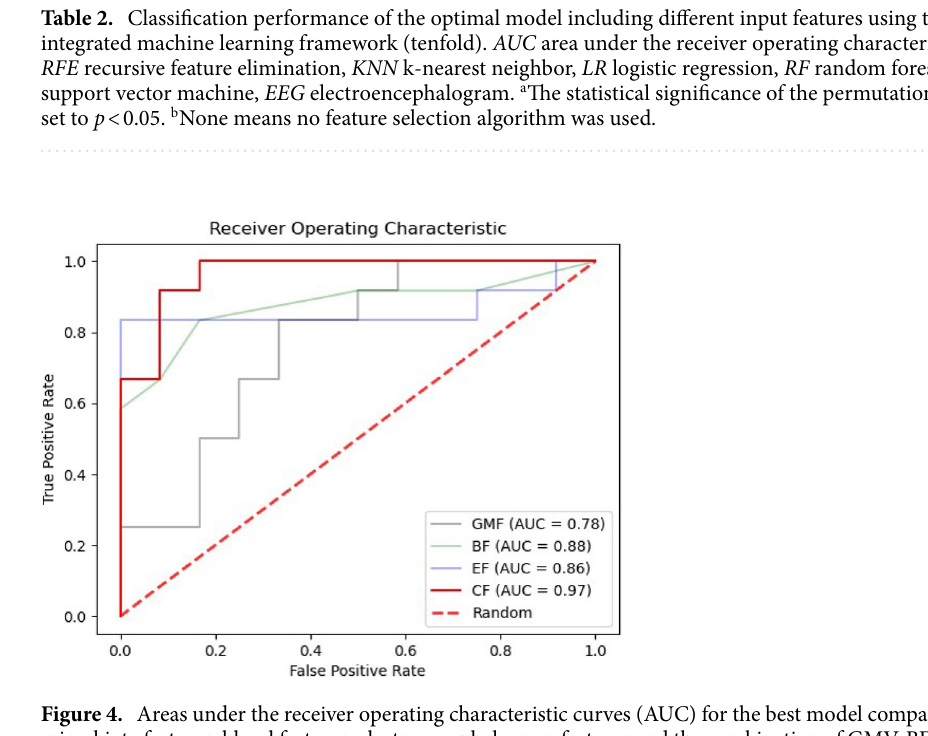
Figure 4. Areas under the receiver operating characteristic curves (AUC) for the best model comparing the gut microbiota features, blood features, electroencephalogram features and the combination of GMV, BF and EF as the input for machine learning. Each curve in the figure represents the ROC curve of the best model using different input features. GMF gut microbiota features, BF blood features, EF electroencephalogram features, CF combined features. This figure was generated by “Visual Studio Code” (Version 1.56, https:// code. visua lstud io.